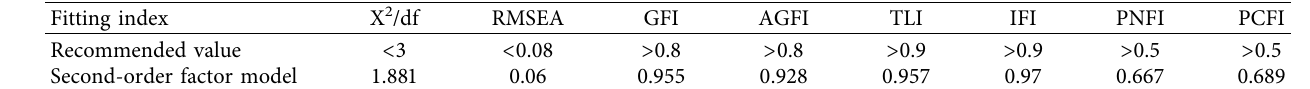
Figure 3: Second-order CFA path analysis chart of internal conditions scale (standardized). Table 6: CFA fitting index of internal conditions scale.